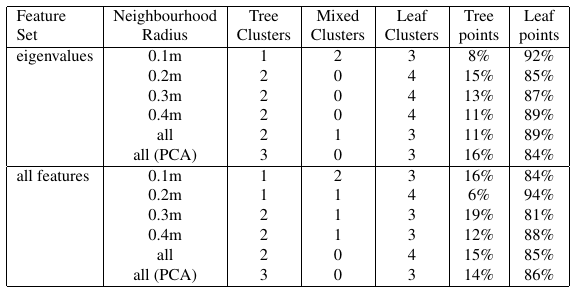
Table 1: Different combinations of features and neighbour- hood sizes tested for with GMM.